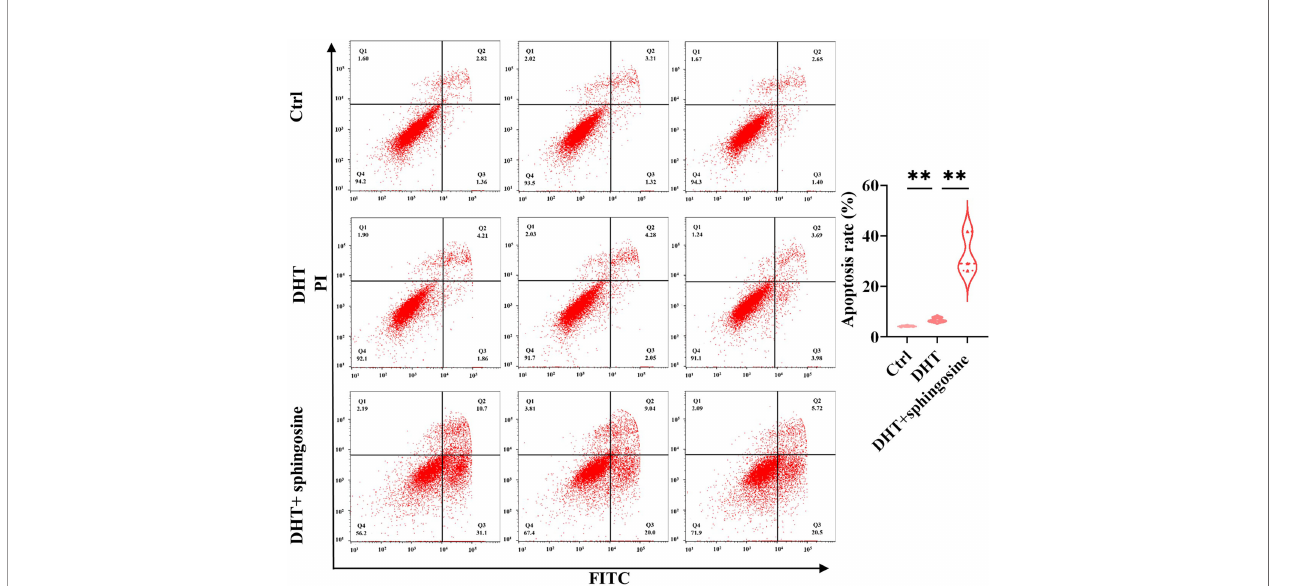
FIGURE 8 | Analysis of the cell apoptosis of KGN cells transfected with sphingosine. The early and late apoptosis rates of KGN cells were compared using PI and FITC. Sphingosine increased the apoptosis of DHT-treated KGN cells. The results are triplicates. DHT , dihydrotestosterone; PI , propidium iodide; FITC , fl uorescein isothiocyanate. Data were analyzed with unpaired Student ’ s t -test. ** p <